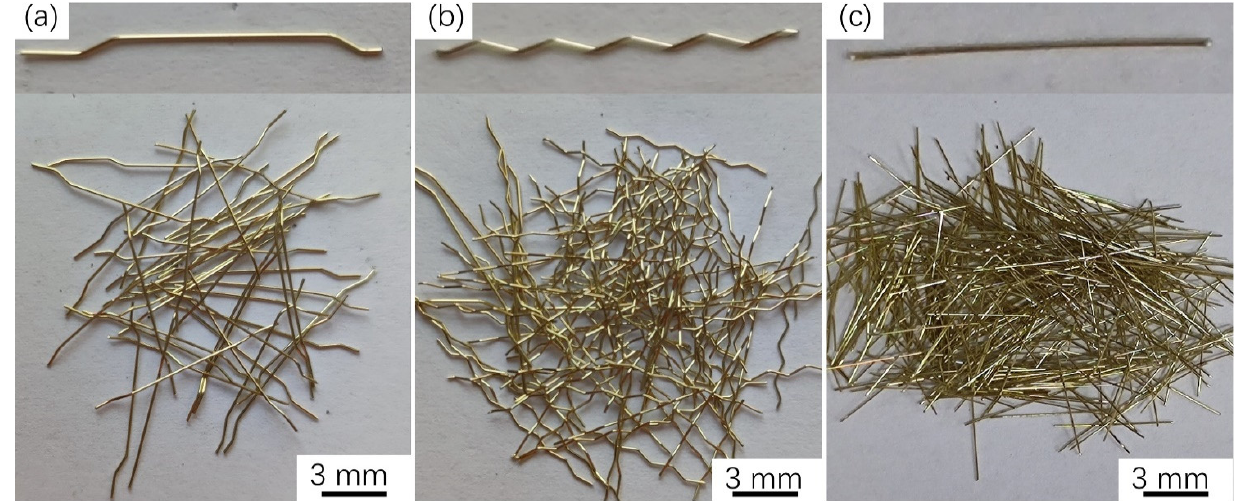
Figure 1. Types of the brass-coated steel fibers: ( a ) Hooked fibers, ( b ) Corrugated fiber, ( c ) Straight fiber.